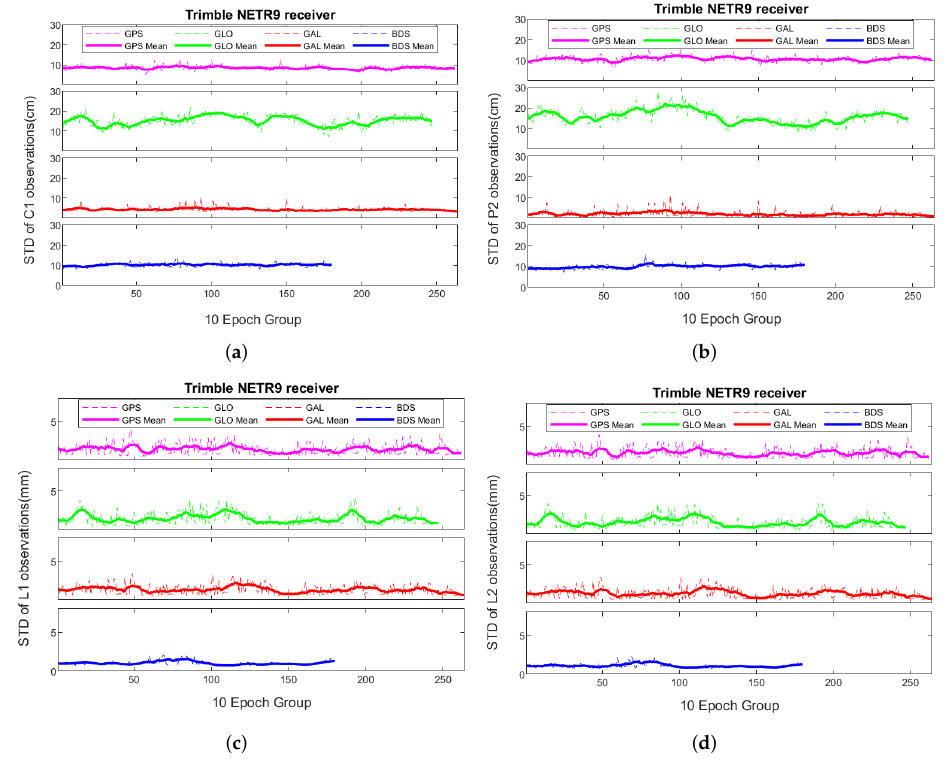
Figure 2. Groupwise estimated standard deviations for each system (dashed line) with their average values in 10 epoch group windows (bold line) over a zero baseline with Trimble NETR9 receiver: ( a , b ) for the C1 and P2 in cm; ( c , d ) for the L1 and L2 in